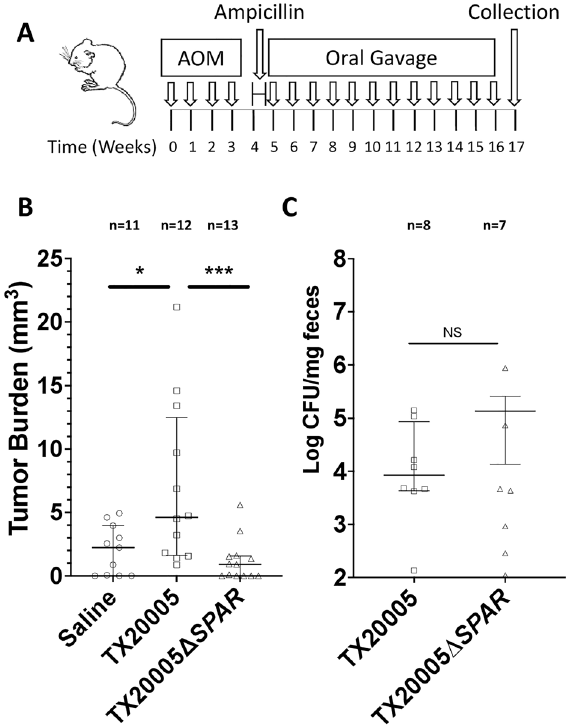
Figure 5. SPAR is critical for Sgg to promote the development of colon tumors. This was performed as described in the “Materials and Methods” section. The procedure is illustrated in ( A ). ( B ) The number and size of macroscopic colon tumors were recorded by blinded observers. Tumor burden is calculated as the sum of tumor volumes per mouse. 11–13 mice were used per group. ( C ) Sgg load in the fecal pellets collected at the experimental endpoint was determined by dilution plating of homogenized pellets onto ESA plates. 7 or 8 mice per group were used. Mann–Whitney test was used for statistical analysis. * p < 0.05; *** p < 0.001; NS, not significant. Median values with interquartile range (IQR) are